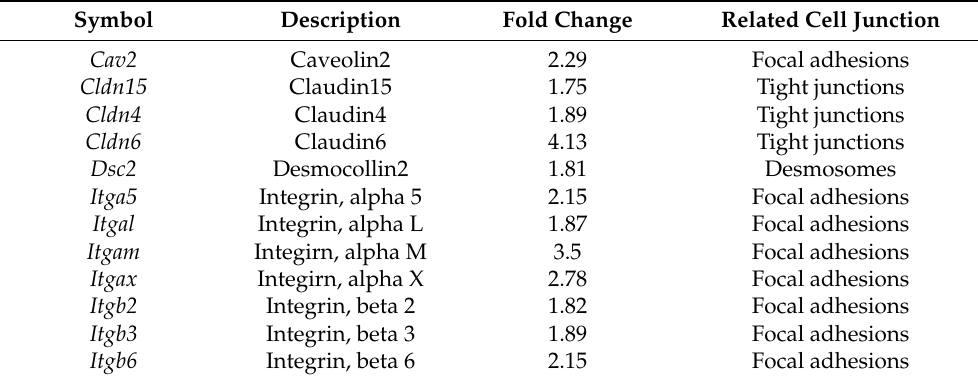
Table 1. Cell junction-related gene